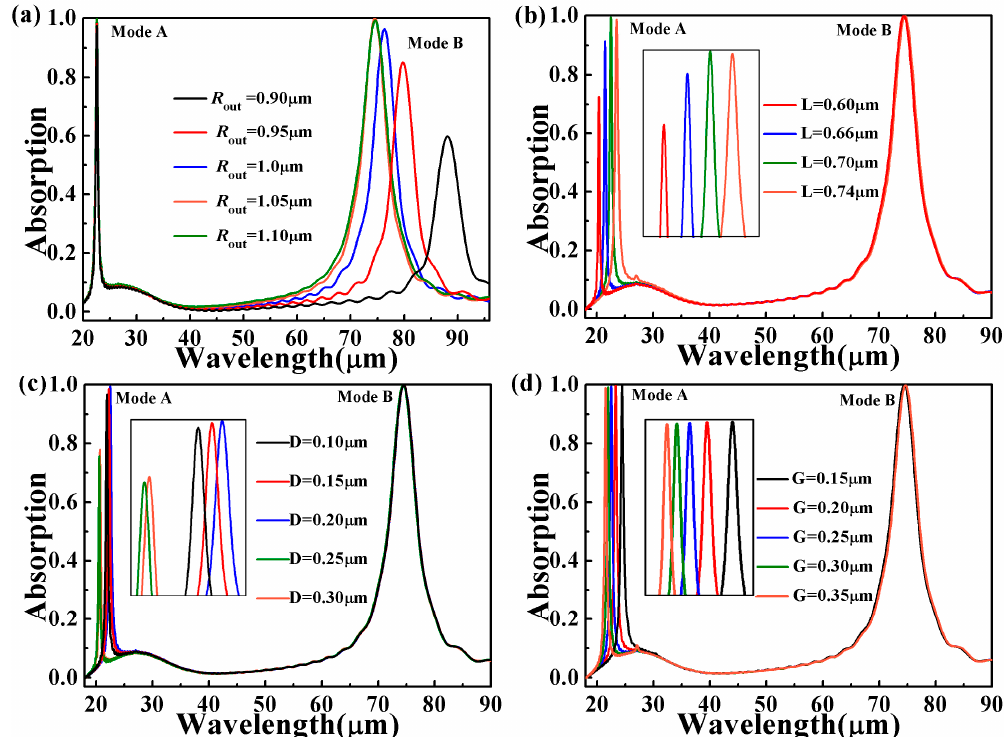
Figure 3. The effect of different parameters of the absorber on the absorption spectrum: ( a ) the outer ring radius of the graphene ( R out ); ( b ) L , ( c ) D , ( d ) G . The Fermi level of graphene is 1.0 eV in (b), (c), and (d). The insert graph is the absorption peak of Mode A or Mode B.